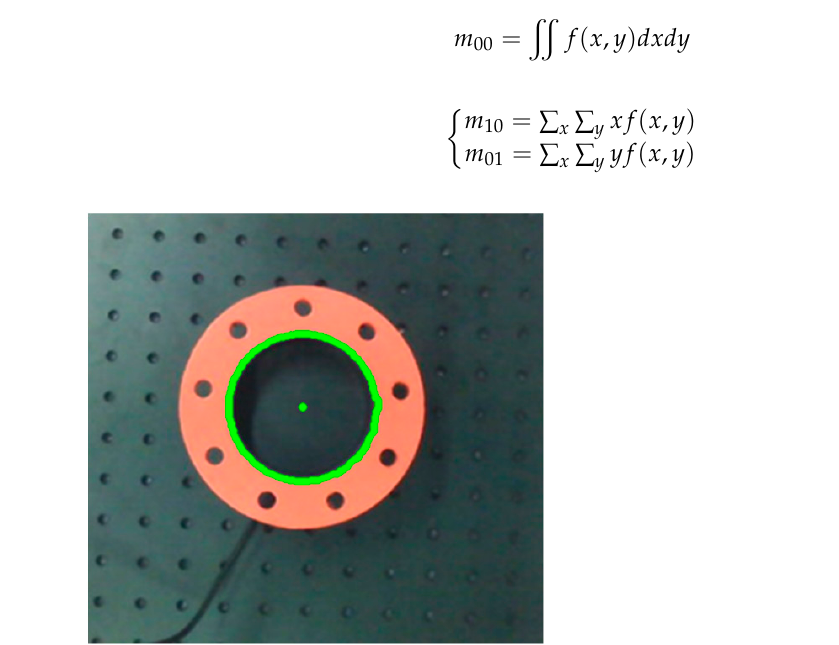
Figure 9. The center of the target